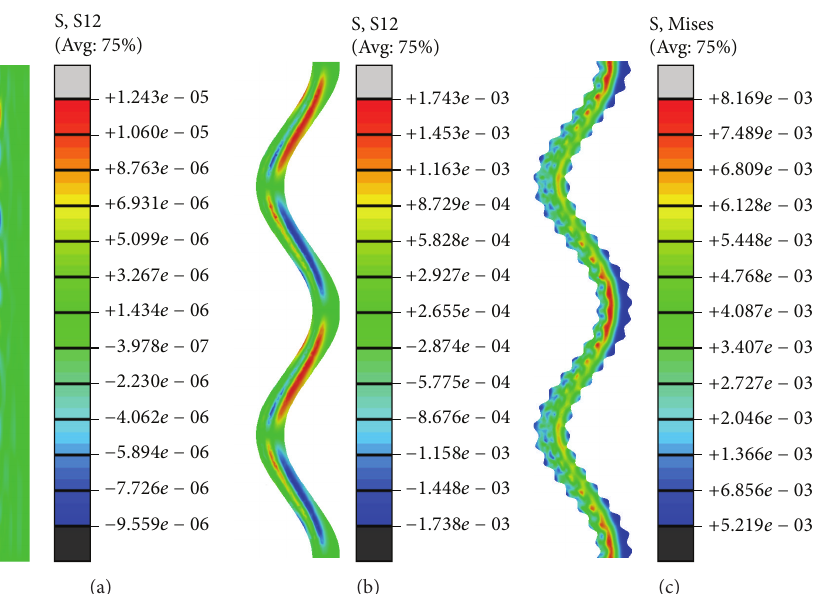
Figure 10: von Mises stress fields in different suture morphologies at 4 𝜇 s: (a) straight suture, (b) pure sinusoidal suture, and (c) two-order hierarchical sinusoidal